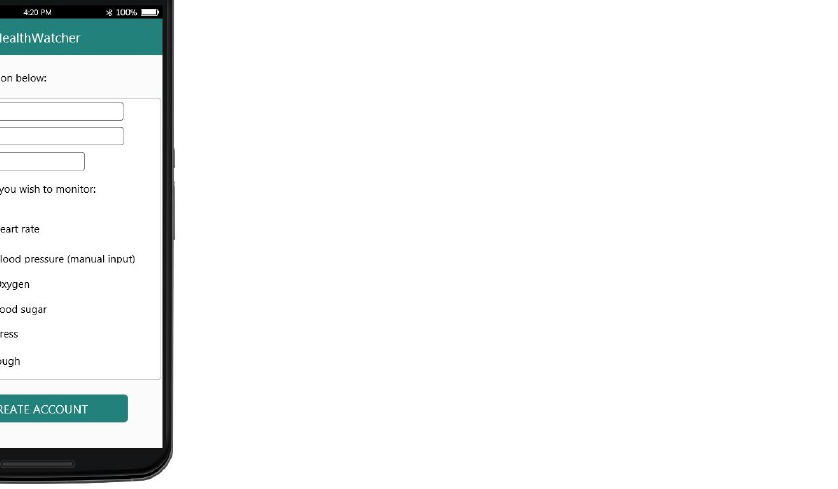
Figure 12. Account information screen, where the user specifies which vital signs he/she wants to monitor.